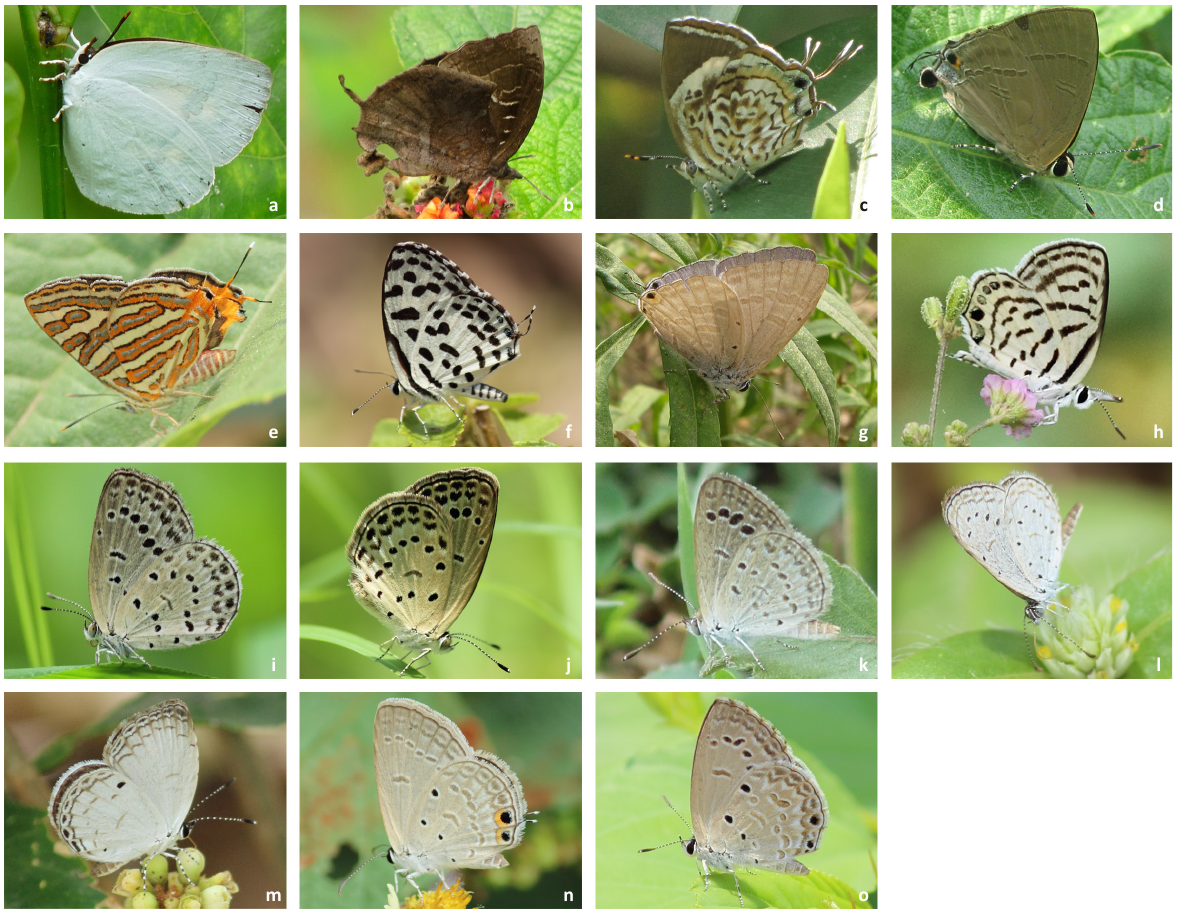
Image 4. Butterflies representing the family Lycaenidae in and around RRS; Chinsurah. a - Indian Sunbeam C. thetis (Drury); b - Falcate Oakblue M. ameria (Hewitson); c - Monkey Puzzle R. amor (Fabricius); d - Slate Flash R.